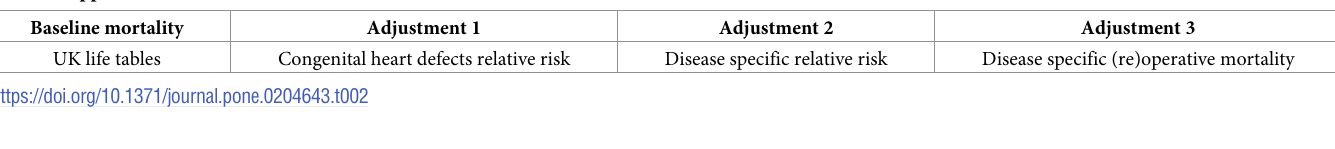
Table 2. Approach to inform survival in the